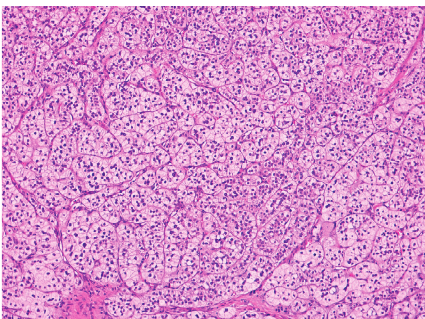
Figure 4: H&E, original magnification x4 and x10)-There is ill- defined multinodular hyperplasia of the cortical fasciculata layer of the adrenal tissue.